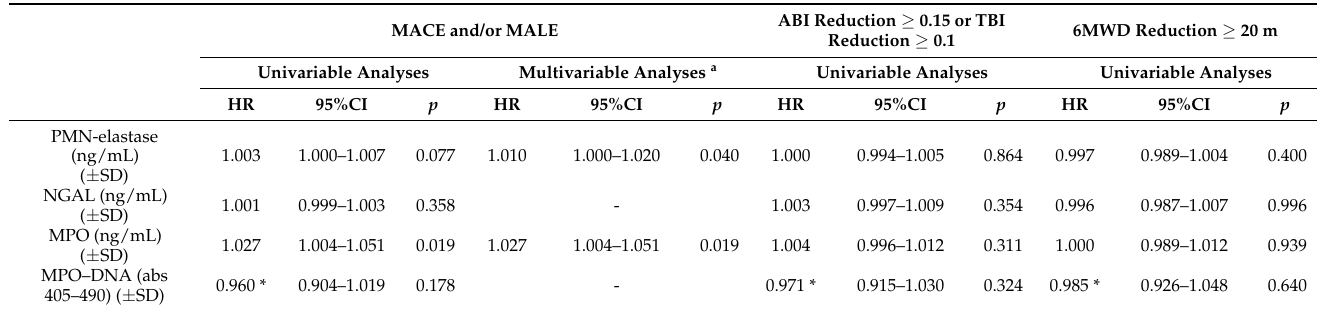
Table 3. Cox and logistic regression analyses of markers of neutrophil activation for outcomes at 6-month follow-up in patients with symptomatic chronic